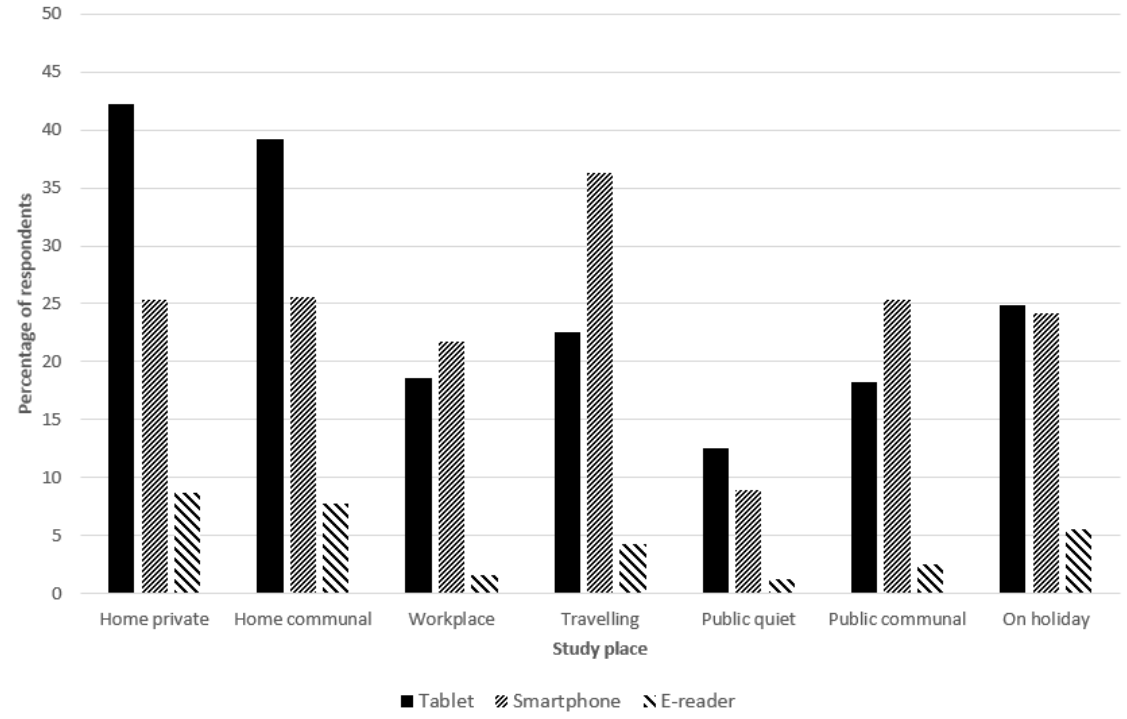
Figure 1. Student use of handheld devices in seven types of study place ( n =446).